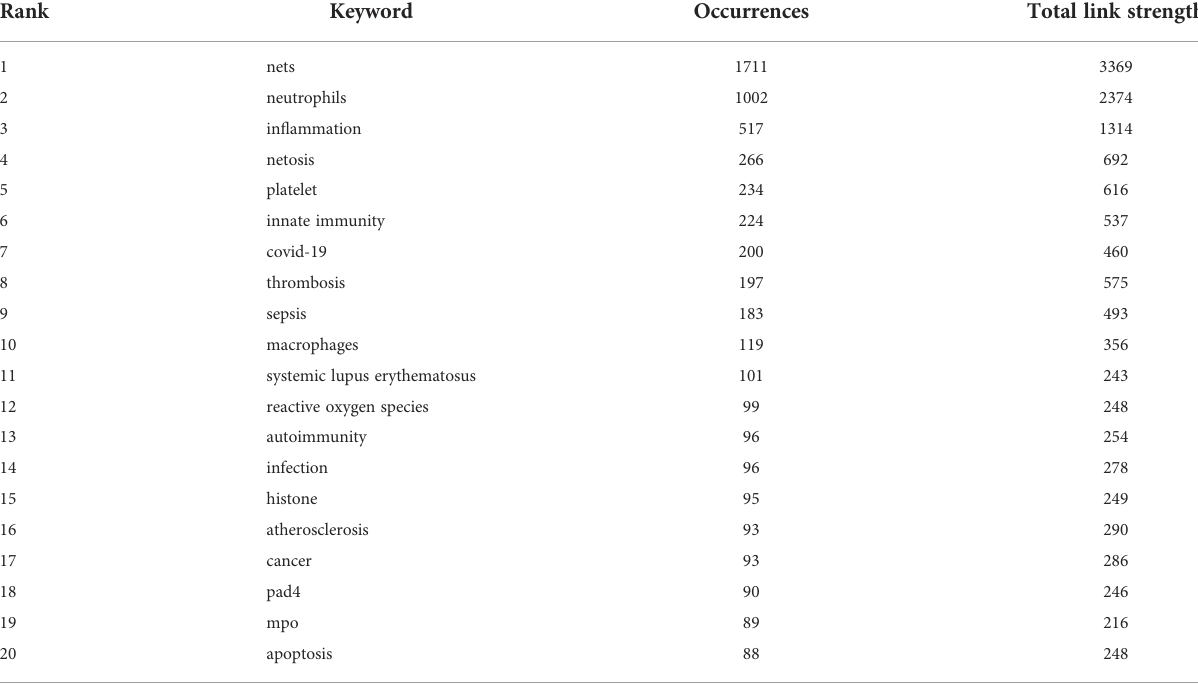
TABLE 5 Top 20 keywords in terms of frequency of occurrence and the corresponding total link strength.